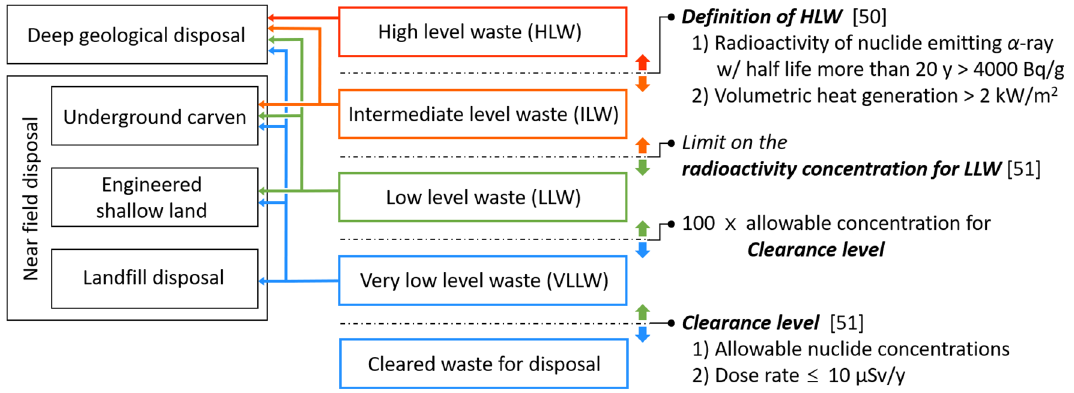
Figure 5. Disposal methods for radioactive waste according to their classification under Korean